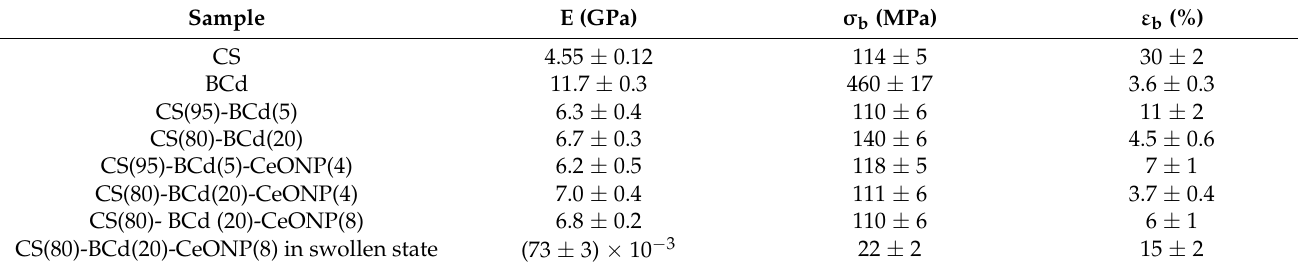
Table 2. Mechanical properties of the polysaccharides and nanocomposite